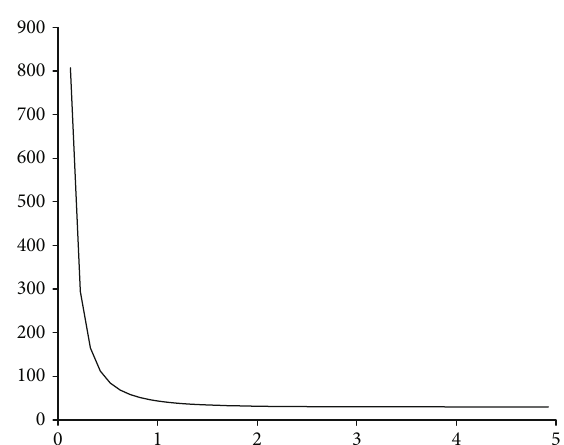
ζ Þ curve in 10 ð